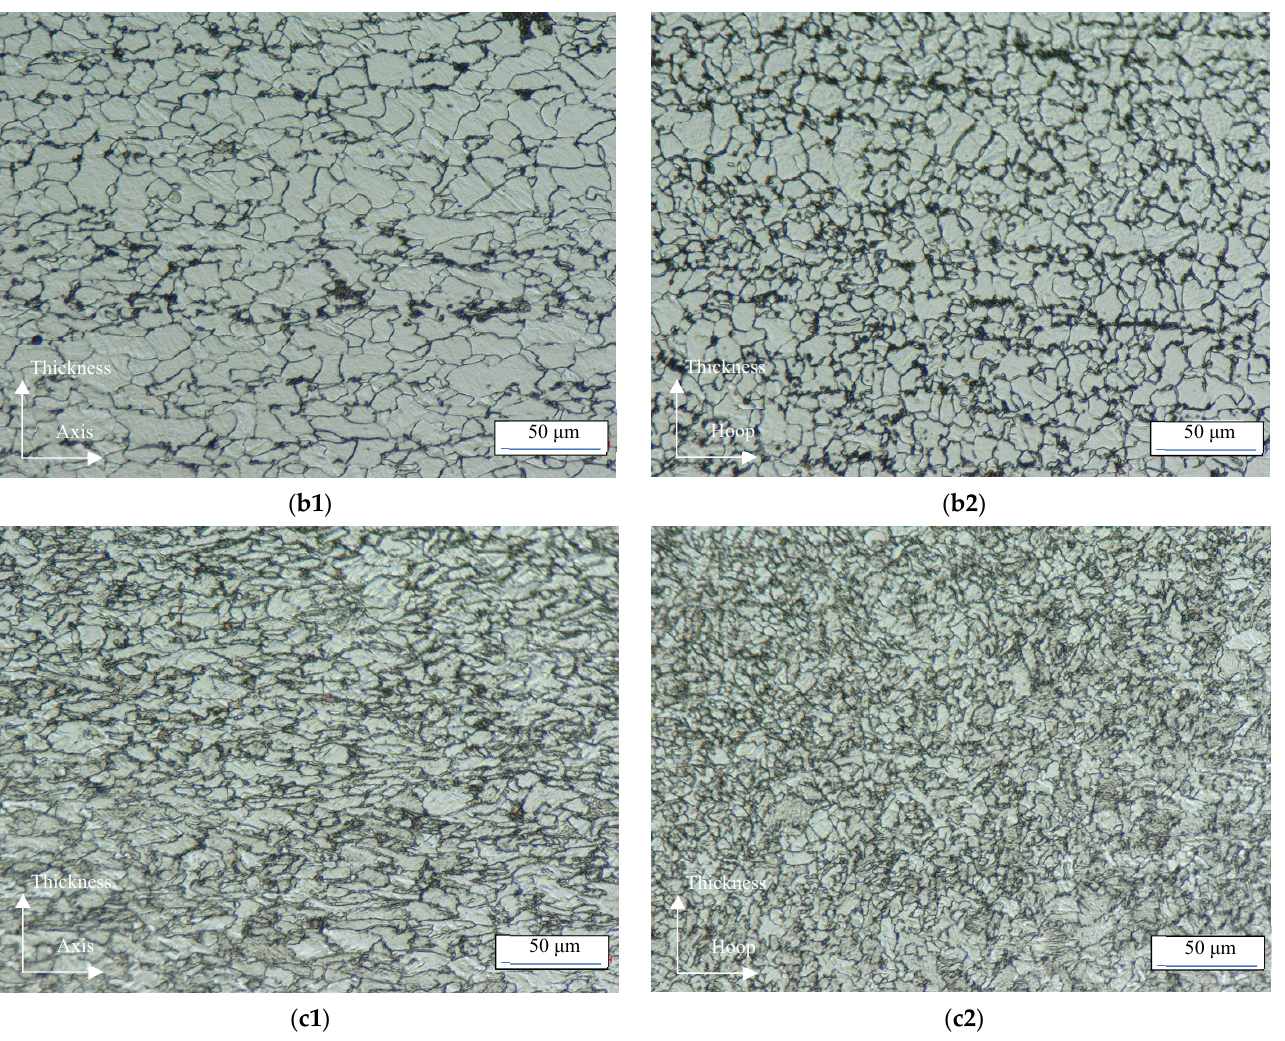
Figure 2. Nital-etched micro-structures of the steel tubes. ( a1 , a2 ) The axis-thickness and hoop- thickness surfaces of tube A. ( b1 , b2 ) The axis-thickness and hoop-thickness surfaces of tube B. ( c1 , c2 ) The axis-thickness and hoop-thickness surfaces of tube C.